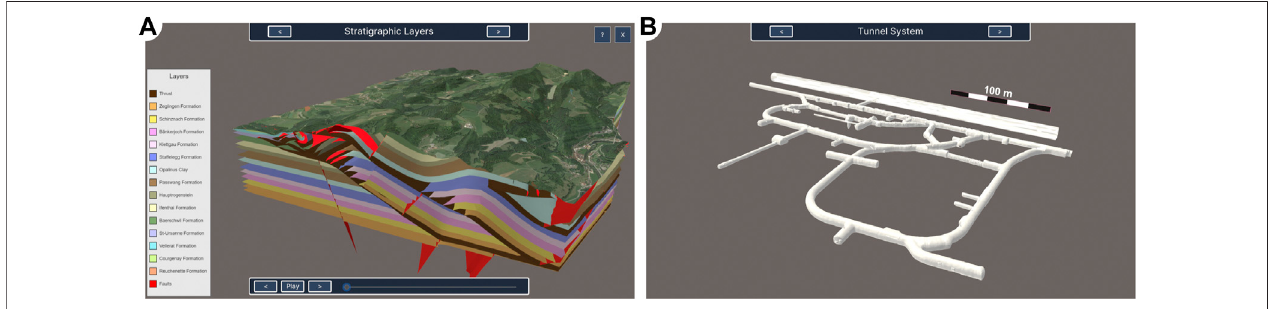
FIGURE2| Twoconsecutiveviewpointswithdifferentscale: (A) arepresentationofthestratigraphiclayerswithadditionaltexturedsurfacedataofthesurrounding terrain from Google (2021) and (B) laser scan data of the tunnel